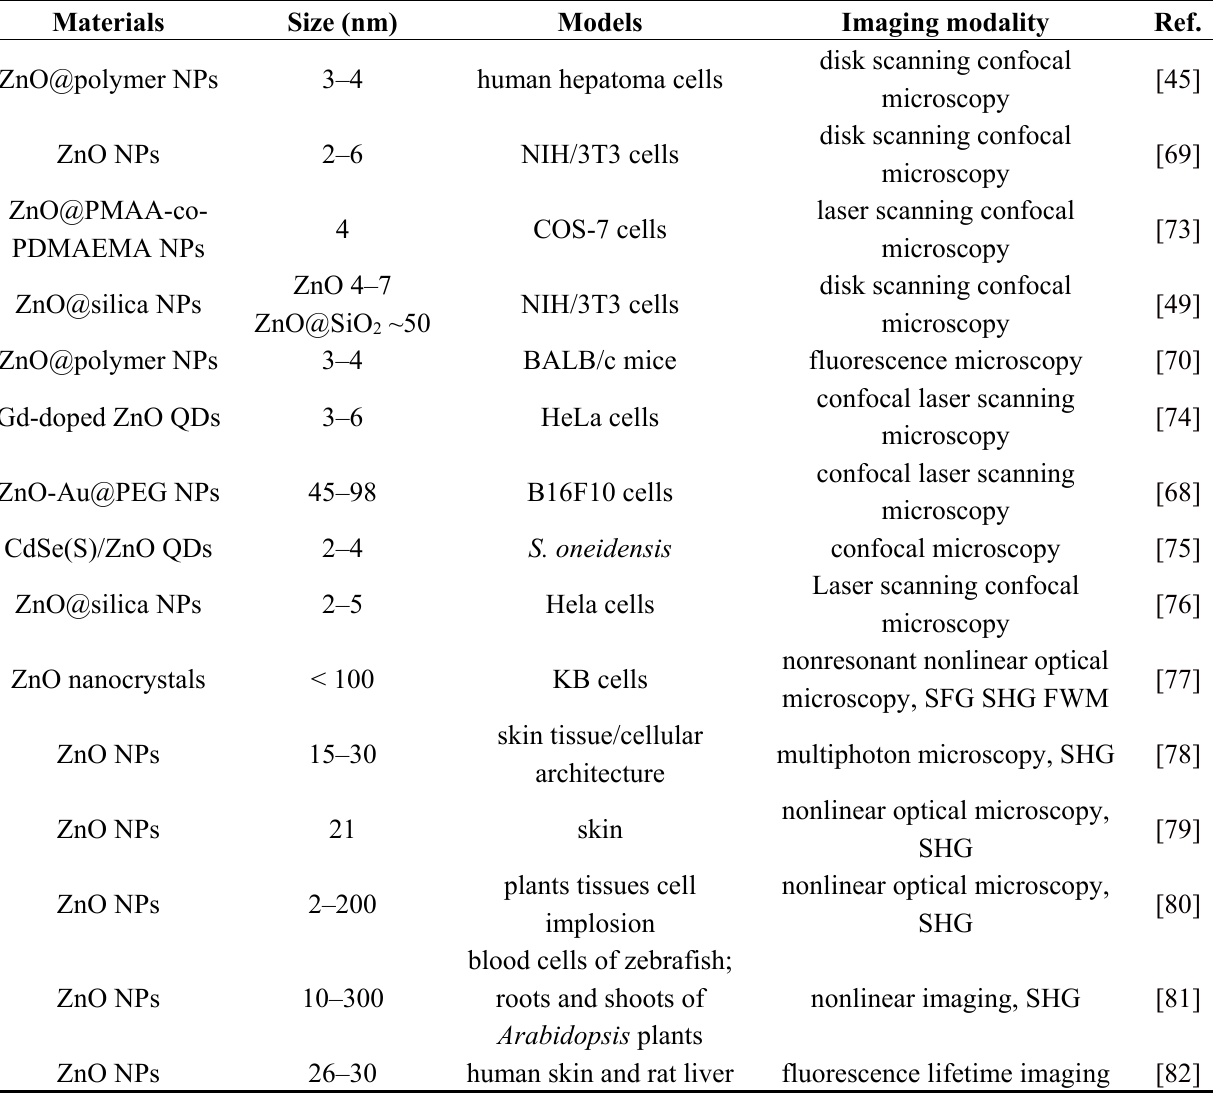
Table 3. Typical researches about biological imaging of ZnO